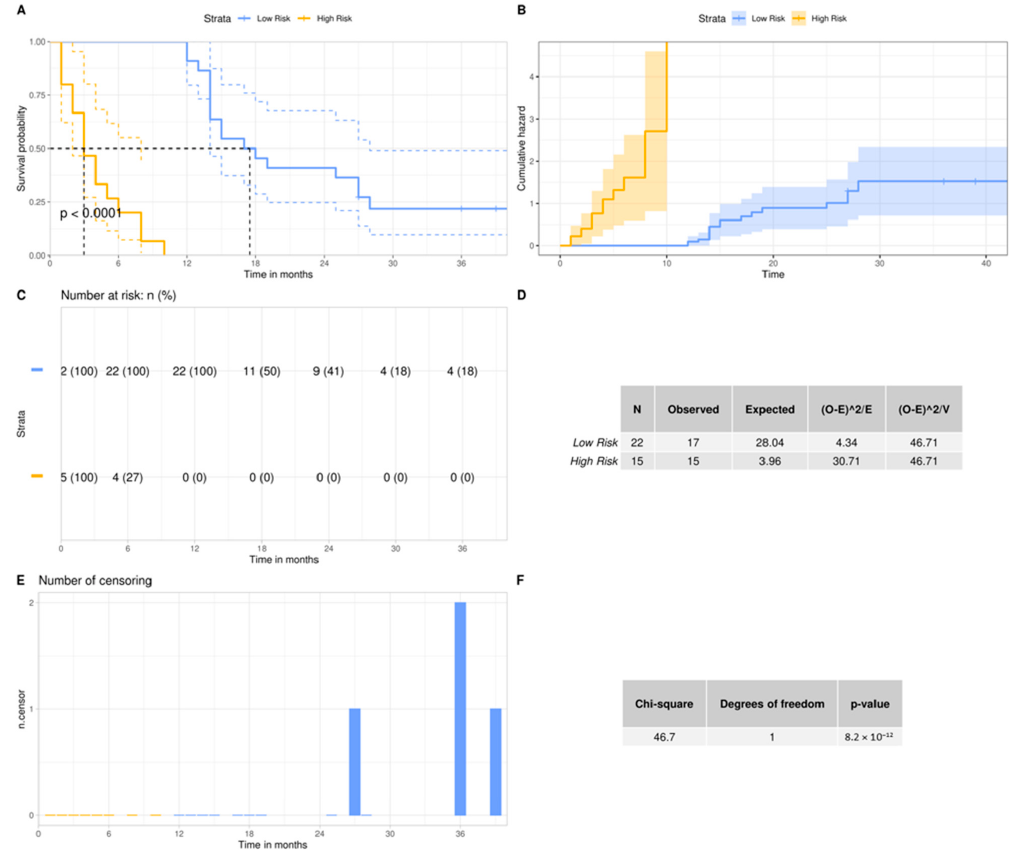
Figure 4. Overall survival probability of the GBM patients according to their risk group : ( A , C , E )